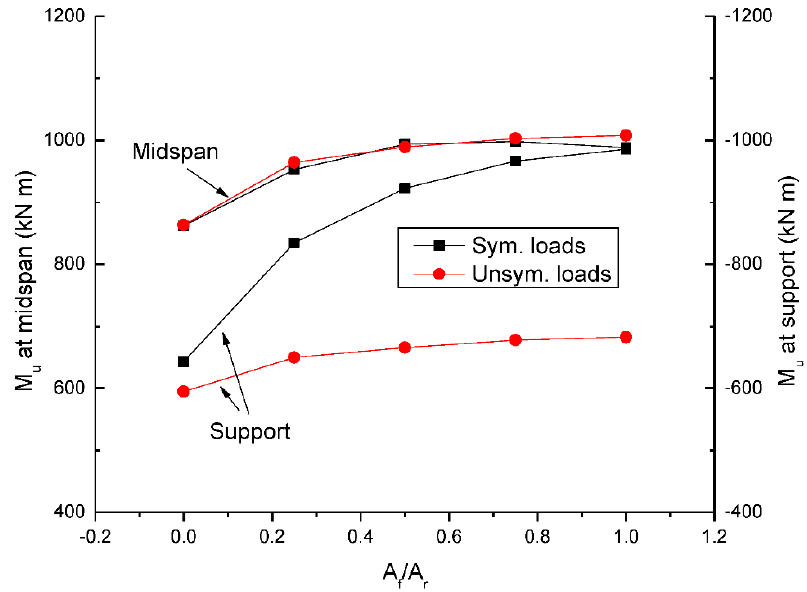
Figure 5. Change in ultimate moment ( M u ) with the hybrid level.